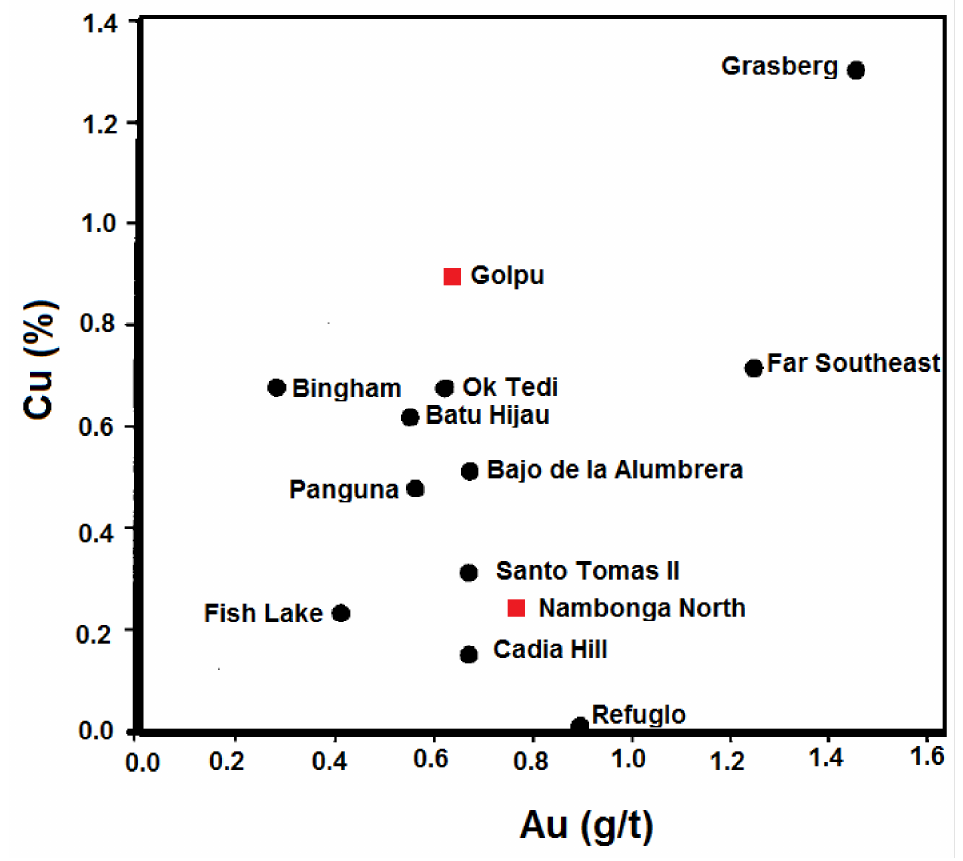
Figure 13. Contents of Au and Cu for the largest Au-rich porphyry Cu deposits in the Circum-Pacific region (Slightly modified after Sillitoe, 1997). All deposits contain >200 t of